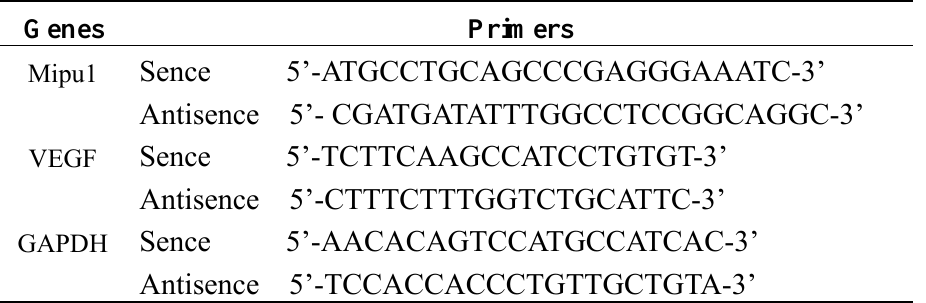
Table 1. The primers for the quantitative real-time